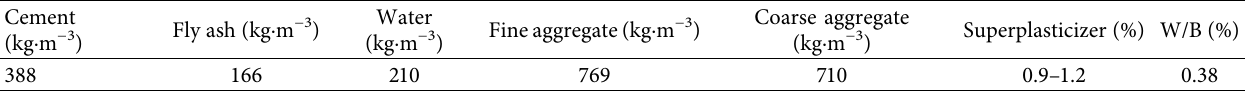
Figure 2: Loading and measuring system. (a) Loading mode. (b) LVDTarrangement. (c) Bottom load-bearing reinforcement strain gauge. (d) Stirrup strain gauge. Table 2: Mix proportion